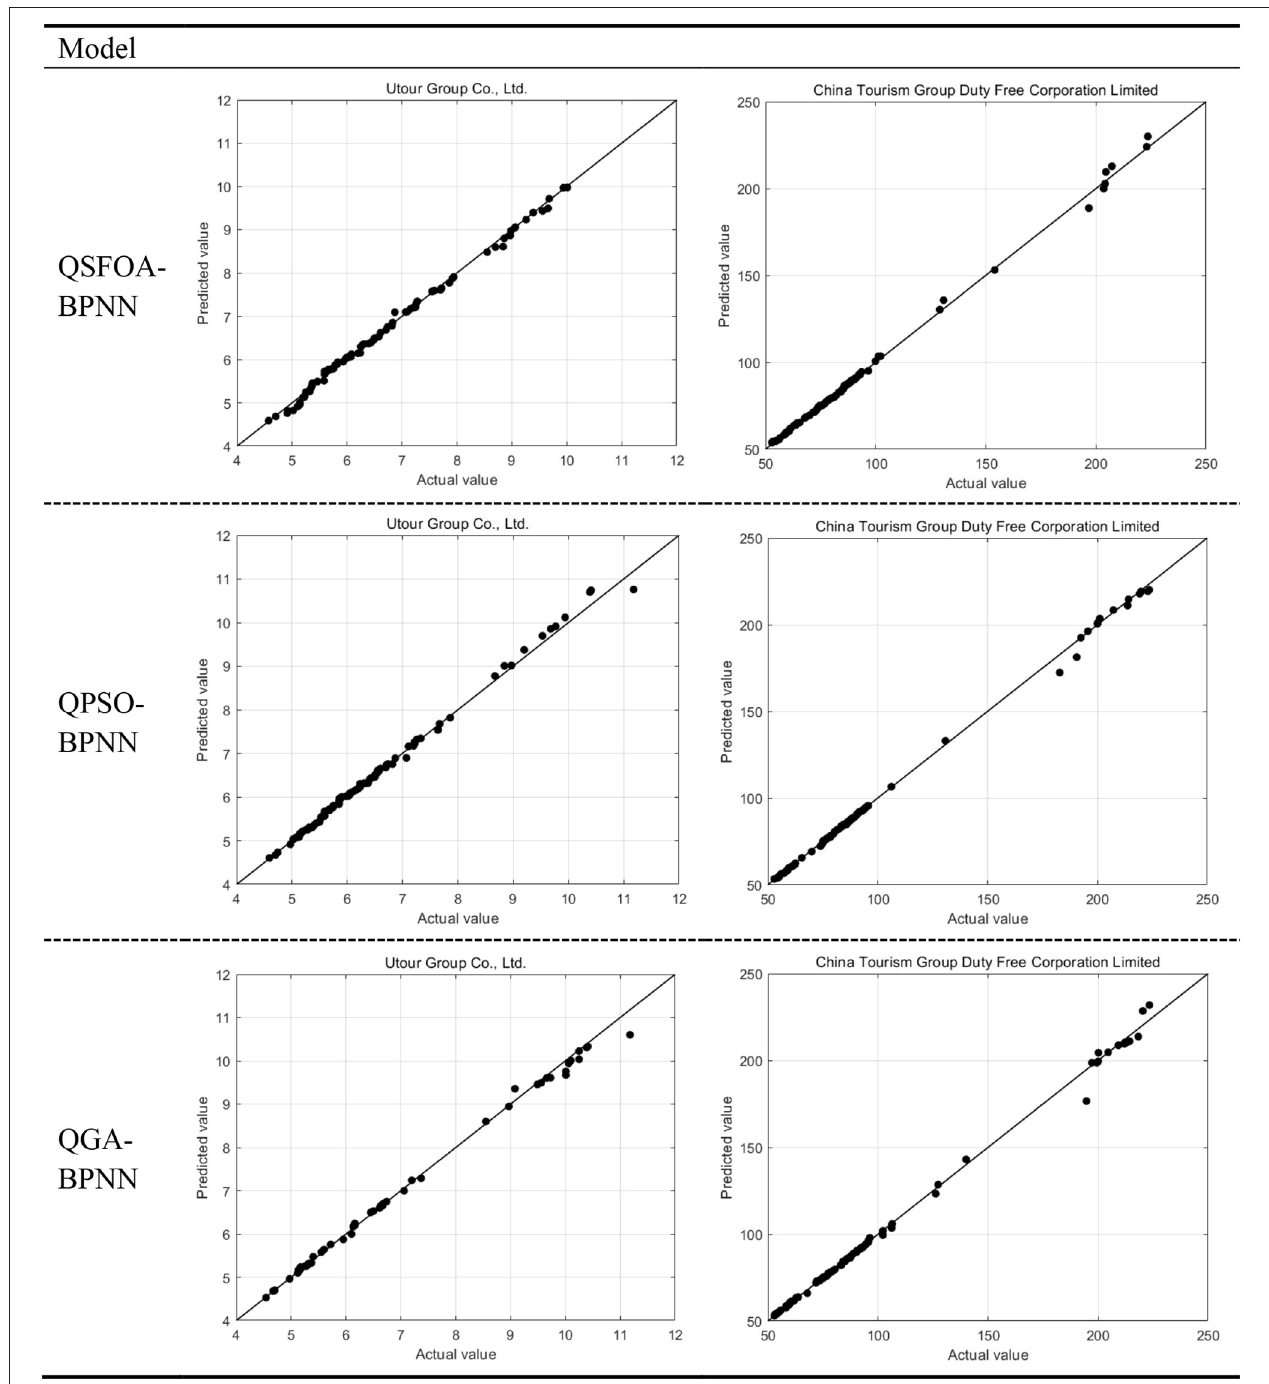
FIGURE 5 | The sample points clustering trend chart of the prediction results.